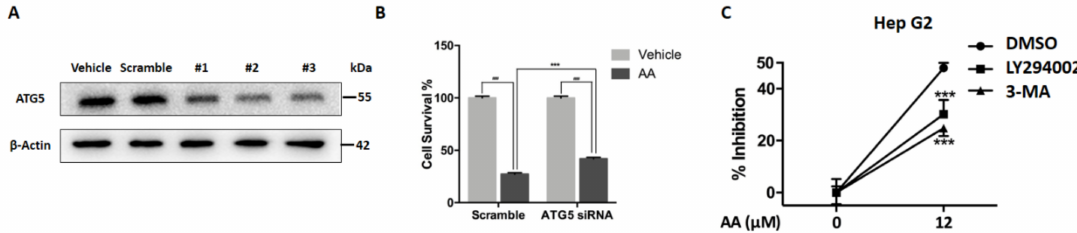
Figure 4. Autophagosome formation contributes to AA induced cytotoxicity. ( A ) ATG5-specific siRNA oligos reduced ATG5 protein levels in HepG2 cells. The third (#3) siRNA oligos was selected for subsequent experiments. ( B ) Atg5 knockdown significantly reverses the inhibitory effects of AA on HepG2 cells, ### p < 0.001, *** p < 0.001, Two-way ANOVA. ( C ) Pretreatment with 3-MA or